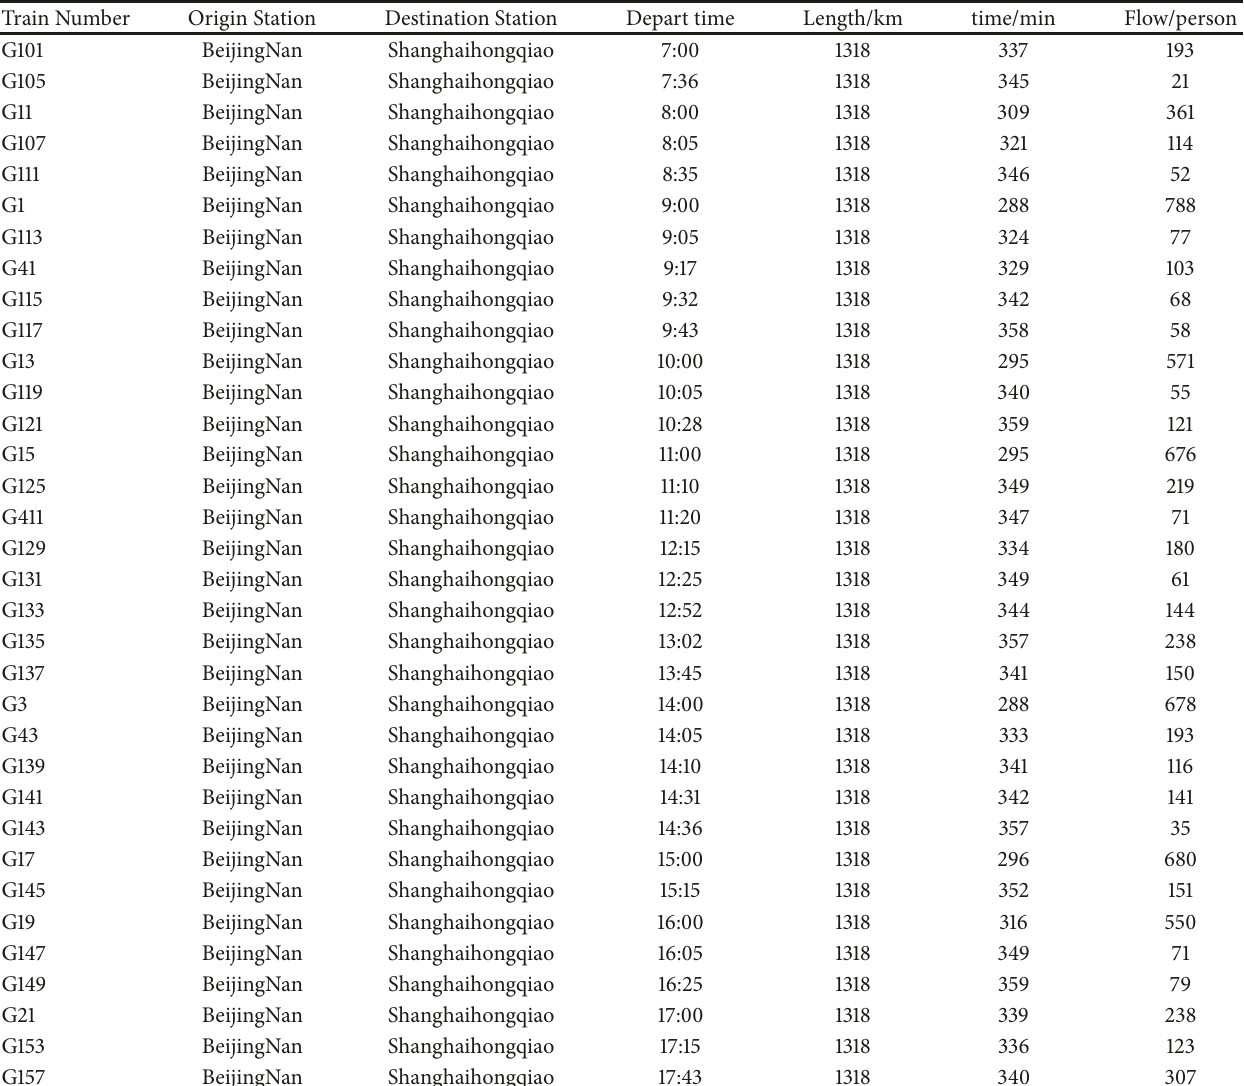
Table 11: The ticket booking data of each itinerary of OD pair Beijing-Shanghai on December 1 st 2015. Train